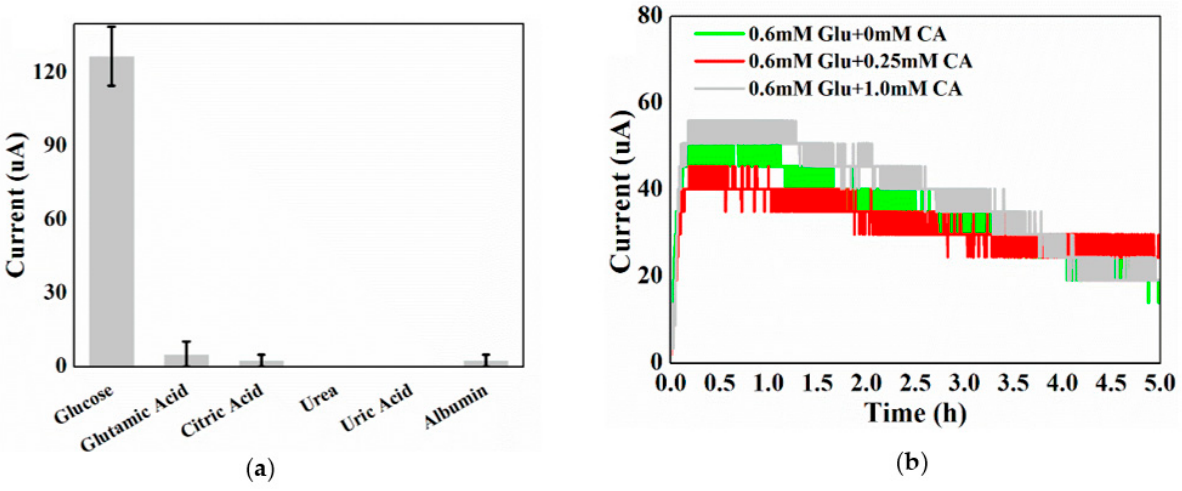
Figure 5. ( a ) Current of the CS in the presence of 2.0 mM representative urine organic matters (albumin concentration = 360 mg/L; obtained in 15 min). ( b ) The current generation of glucose mixed with different concentrations of citric acid (biofilm cultured by glucose; in the figure: Glu—glucose, CA—citric acid). All results were obtained from CS.